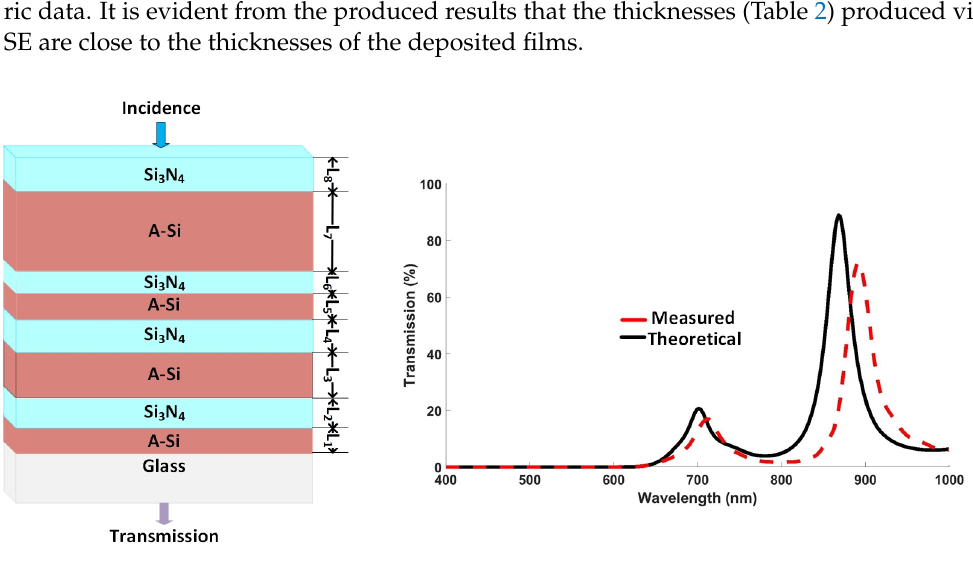
Figure 9. Theoretical and experimental results for multilayered cascaded thin-film